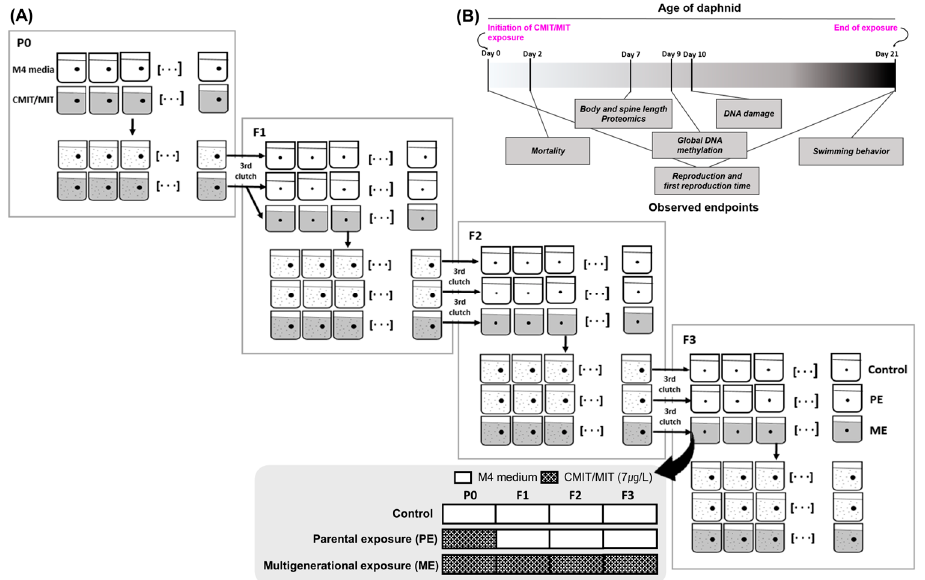
Figure 1. Experimental workflow for multigenerational studies: ( A ) Illustration of three different exposure designs (control, parental exposure, and multigenerational exposure) across four generations (P0: parental generation; F1: first filial generation; F2: second filial generation; F3: third filial generation). The third clutch of female daphnids was used for the next generation. ( B ) Detailed experimental schedules for the assessment of various endpoints within a single generation. Exposure was initiated with neonates on day 0 and ended on day 21.